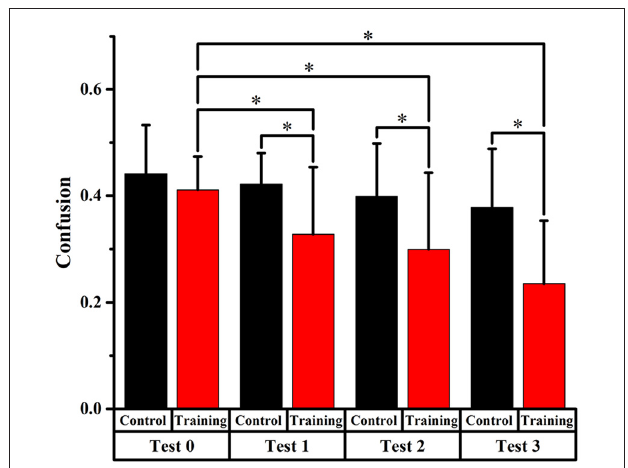
FIGURE 4 | Comparison of front-back confusion ratio for the audiovisual training and control groups between pre- and post-test at total angles. ∗ Meant the difference was significant ( P < 0.05).